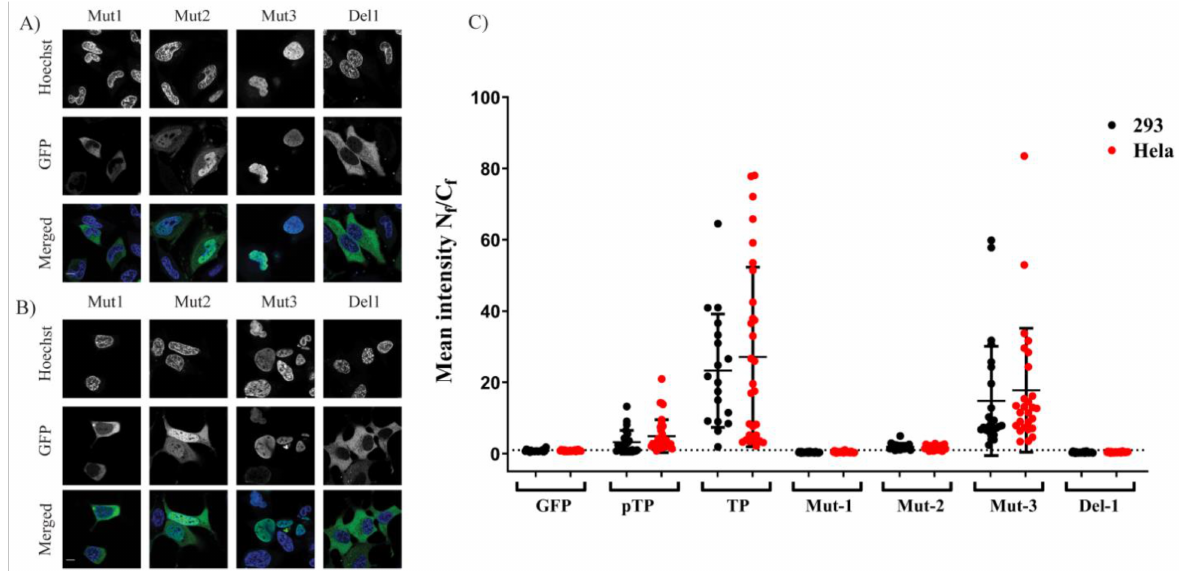
Figure 3. Expression and localisation TP mutants. Specific locations in TP–GFP plasmid were either mutated or deleted as represented in Figure 1. HeLa ( A ) or 293A ( B ) cells were imaged and were presented as detailed in Figure 2 legend. Bar = 10 µ M. ( C ) The mean fluorescence intensity ratio between the nucleus and cytoplasm of the mutants. Data were calculated and plotted similar to Figure 2B. Scale bar = 10 µ